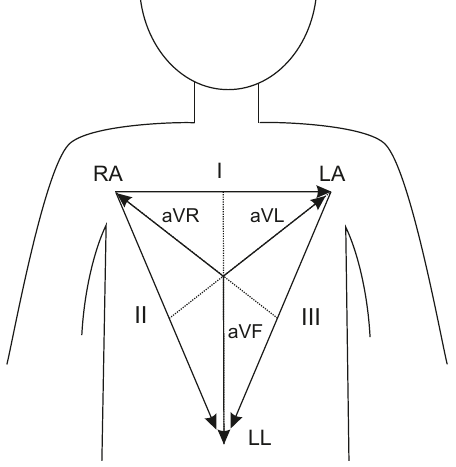
Figure 1. Diagram of electrocardiogram (ECG) lead relationships for ECG electrodes right arm (RA), left arm (LA) and left leg (LL).